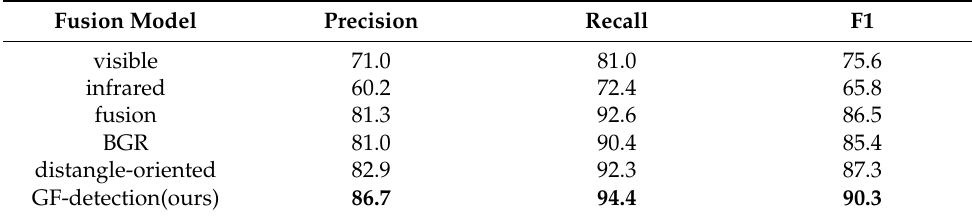
Table 2. Comparison results of six fusion models with IoU set as 0.5.